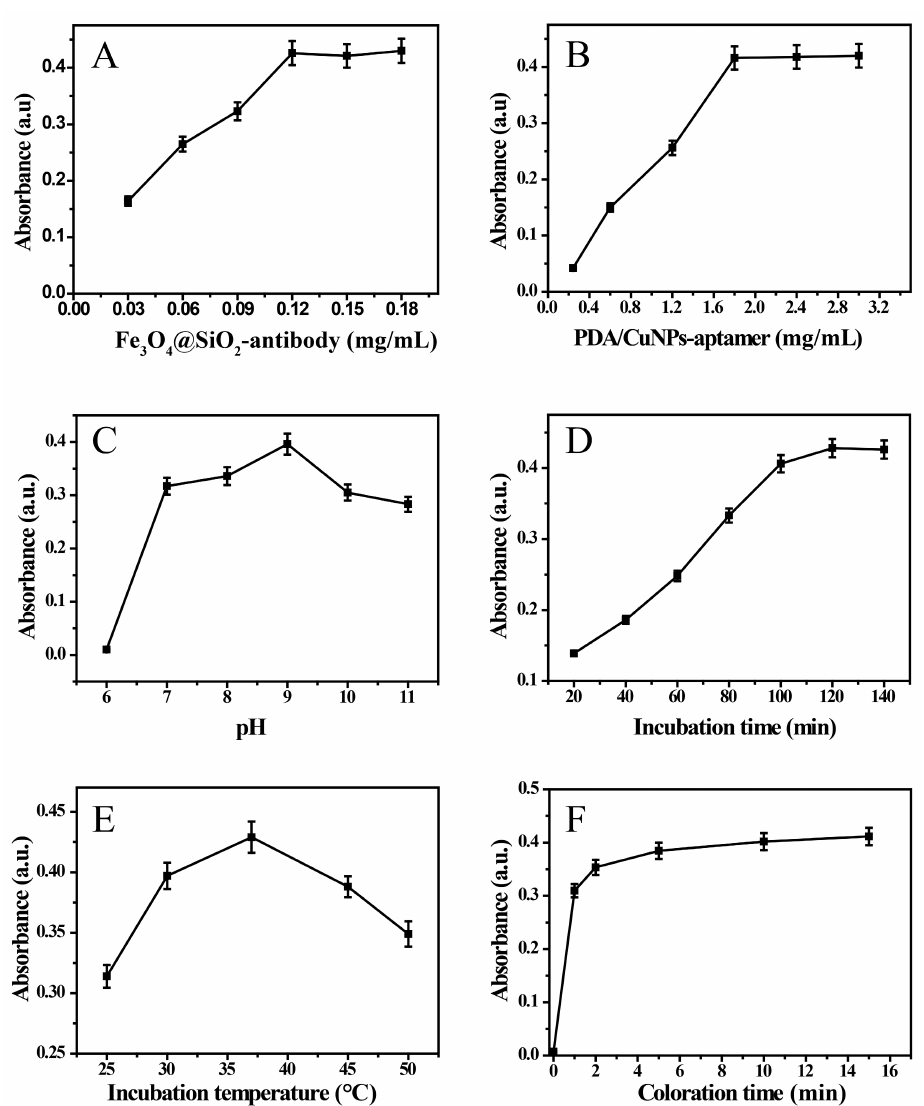
Figure 3. Effects of various concentration of Fe 3 O 4 @SiO 2 -antibody ( A ) and PDA/CuNPs-aptamer ( B ), pH ( C ), incubation time ( D ), incubation temperature ( E ) and coloration time ( F ) on signal intensity. MC-LR concentration was 25 nM. Error bars are standard deviations across three repeated experiments.